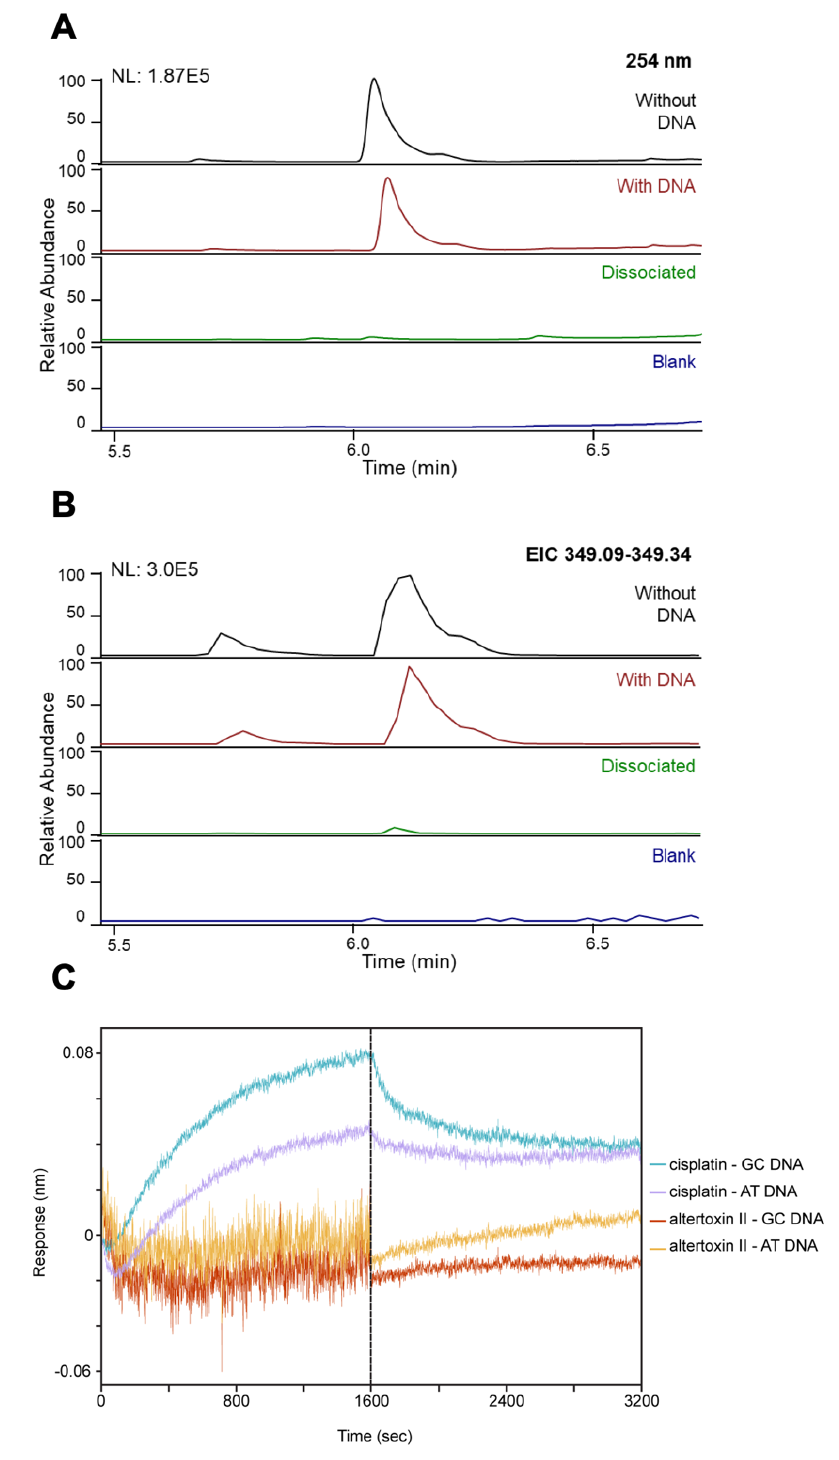
Figure 6. Altertoxin II does not directly bind to DNA. ( A , B ) DNA binding assay results of ATXII using LLAMAS. The UV chromatograms (λ 254 nm) and the extracted ion chromatogram (EIC) analysis revealed that ATXII does not show a recognizable DNA binding activity. ( C ) BioLayer interferometry binding sensorgrams for ATXII and cisplatin against GC- and AT-rich DNA (association step 0–1600 s and buffer dissociation step 1600–3200 s). Compounds evaluated at 125 µ M against biotinylated, double-stranded DNA immobilized on streptavidin.